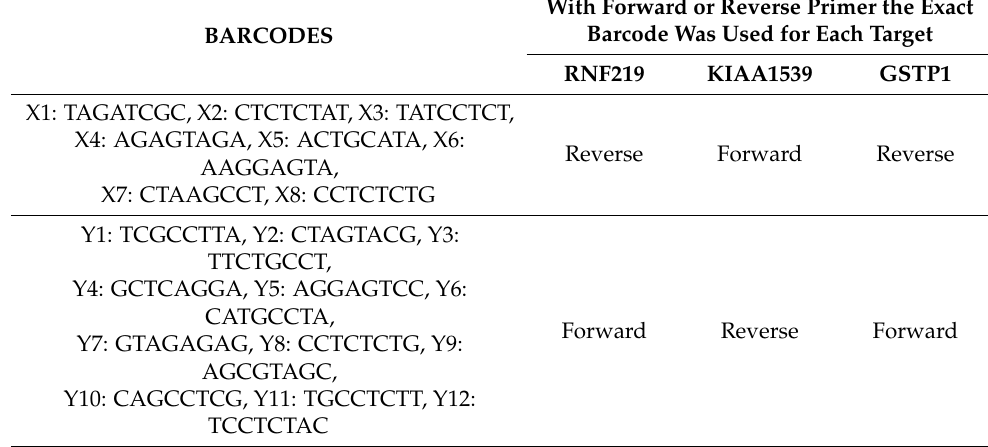
Table 3. Barcodes